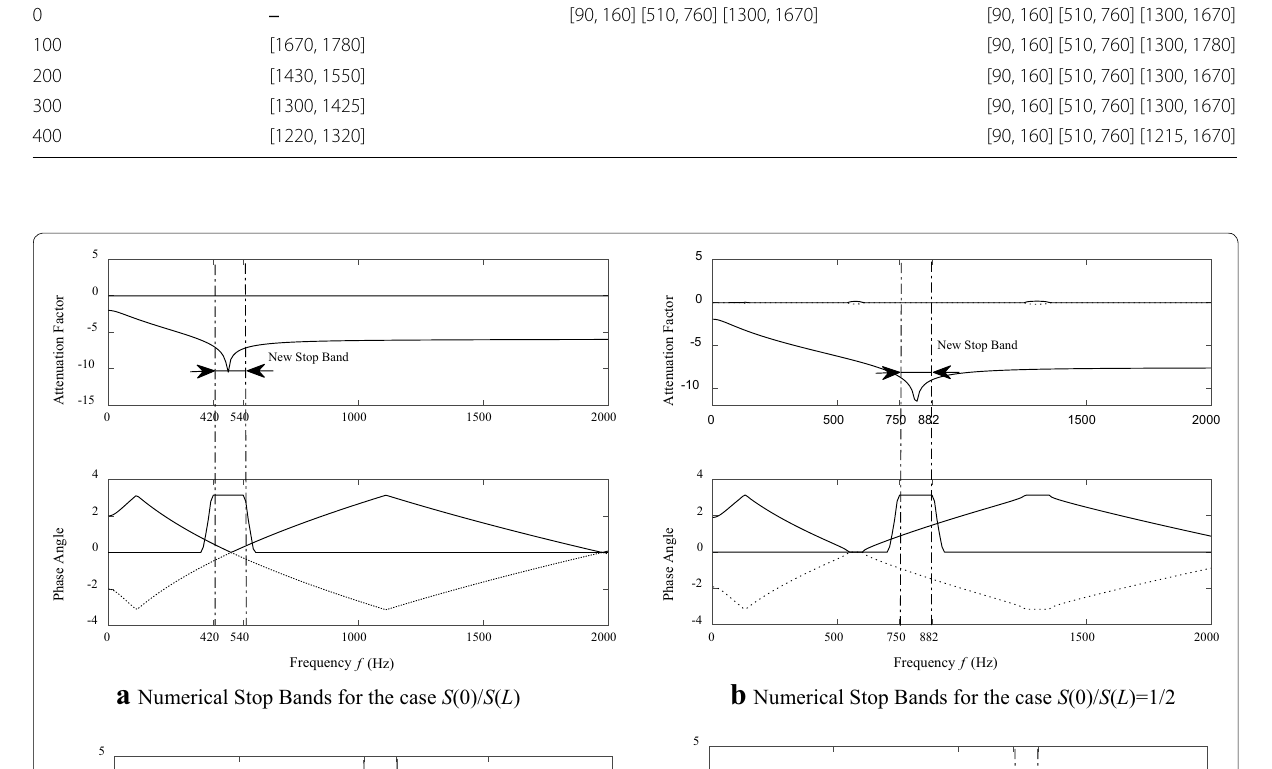
Table 3 The Stop Bands of Numerical Simulation with different axial forces Axial Force F (N)